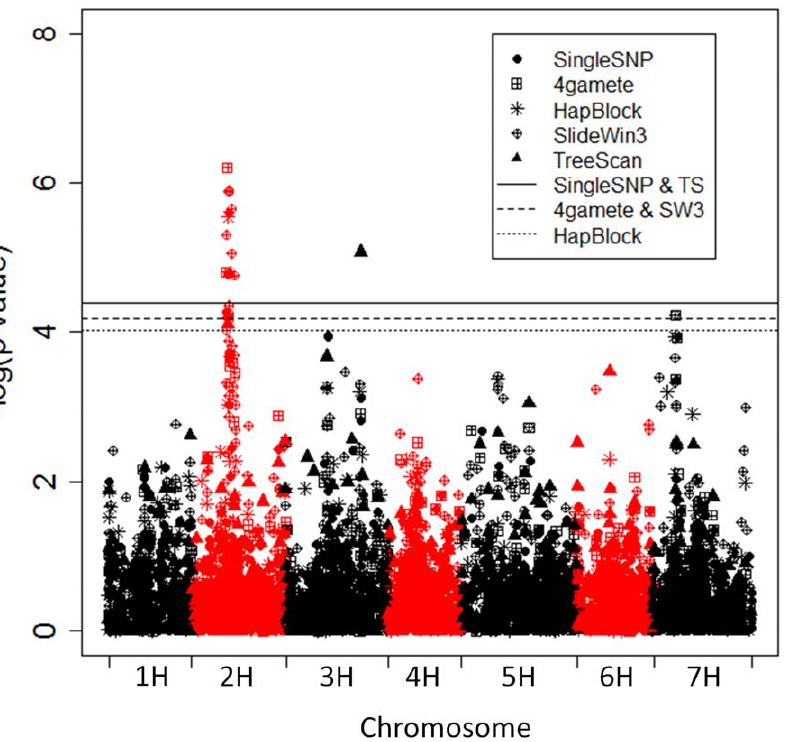
Figure 2. Manhattan plot showing significance of each marker. Markers are plotted on the x-axis according to their genetic position on each chromosome. Horizontal solid, dashed, and dotted lines correspond to an experiment-wise error rate of 0.05 for the single SNP, 4gamete, SlideWin3 (SW3), HapBlock, and TreeScan (TS) analyses as indicated in the legend.